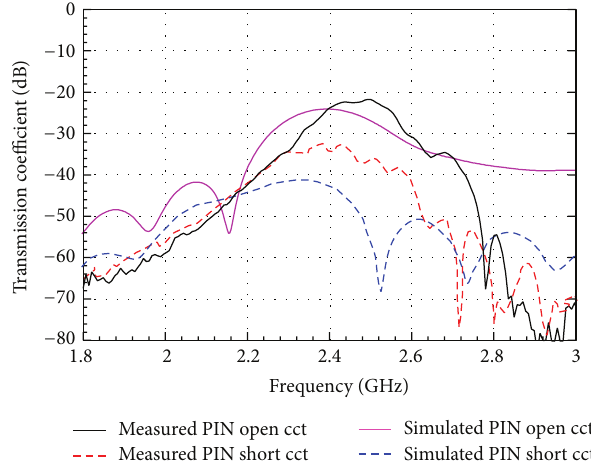
Figure 10: Measured and simulated transmission coefficients ( S 21 ) between switchable mode antennas.